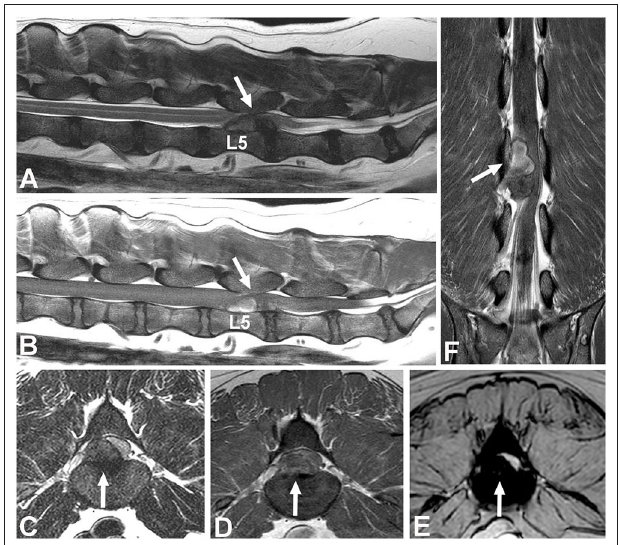
FIGURE 6 | Images of a female spayed, 6-year-old, mixed breed dog with an acute onset of paraparesis, spinal pain, and fecal and urinary incontinence. (A) Sagittal T2W image showing a large mass with mixed signal intensity between L5-6 (arrow). (B) Sagittal T1W image showing that the cranial aspect of the mass is hyperintense (arrow). (C) Transverse T2 image showing severe spinal cord compression caused by a large hypointense mass between L5-6 (arrow). (D) Transverse T1W contrast-enhanced image showing mild heterogeneous contrast enhancement of the hypointense lesion. (E) Gradient echo image showing marked hypointensity. (F) Dorsal T1W contrast-enhanced image showing contrast enhancement of the cranial aspect of the compressive lesion. Note the length of the compressive lesion. Surgical decompression and biopsy confirmed that the compressive material was extruded intervertebral disc with